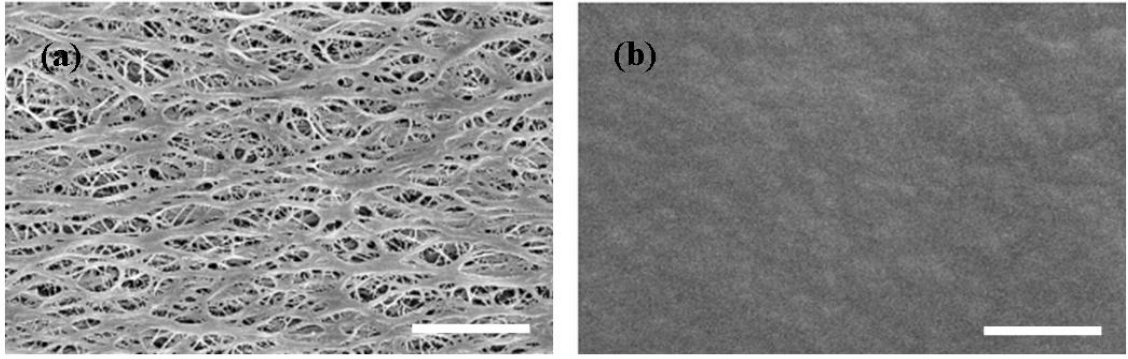
Figure 2. SEM images of (a) PE and (b) PE separators filled with polymer electrolyte (scale bar: 5  m). Reproduced with permission from Reference [48]. © 2006 Elsevier